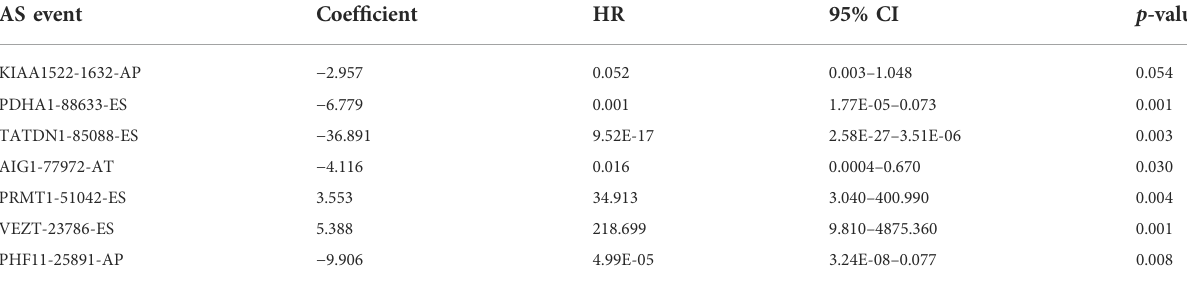
TABLE 3 Details of the selected AS events based on multivariate Cox